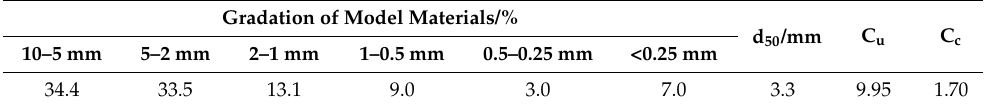
Table 3. Particle size distribution characteristics of the tested